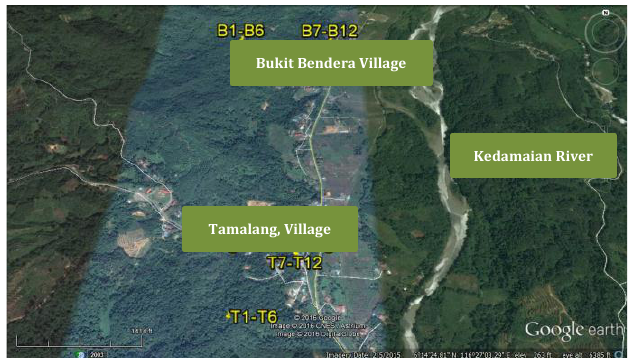
Figure 1: Locations of Bukit Bendera and Tamalang Village, Kota Belud Sabah